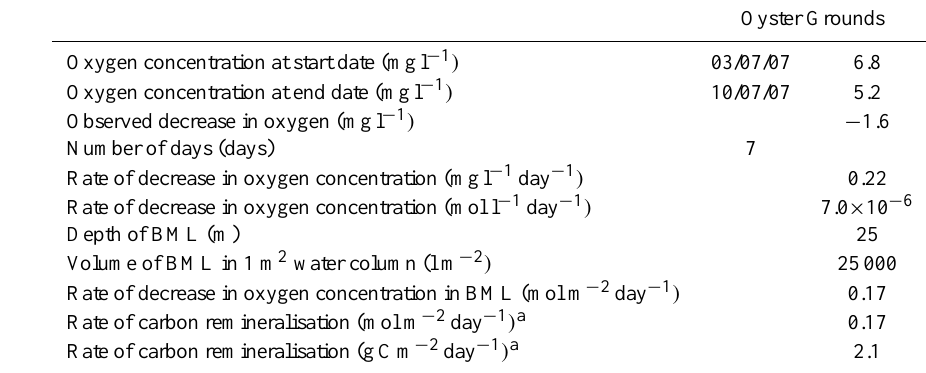
Table 5. Estimate of carbon remineralisation accounted for by pulsed decrease in oxygen concentration at Oyster